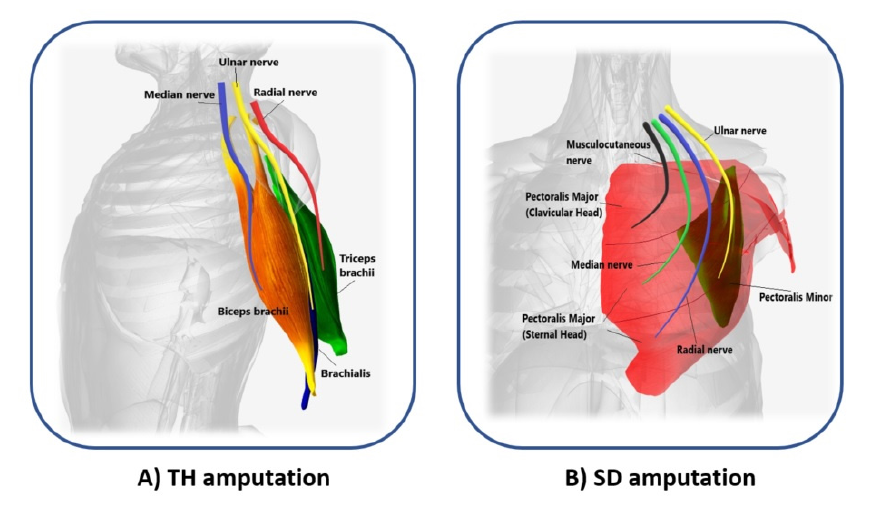
Figure 3. Scheme of the reinnervated sites for different levels of amputation. ( A ) Median (blue), ulnar (yellow), and radial (red) nerves transfer on biceps brachii (orange), brachialis (violet), and triceps brachii (green) muscles of transhumeral (TH) amputees; ( B ) Musculocutaneous (black), median (light green), radial (blue), and ulnar (yellow) nerves transfer on pectoralis major (clavicular and sternal head, in red), and pectoralis minor muscles (dark green) of shoulder disarticulation (SD)